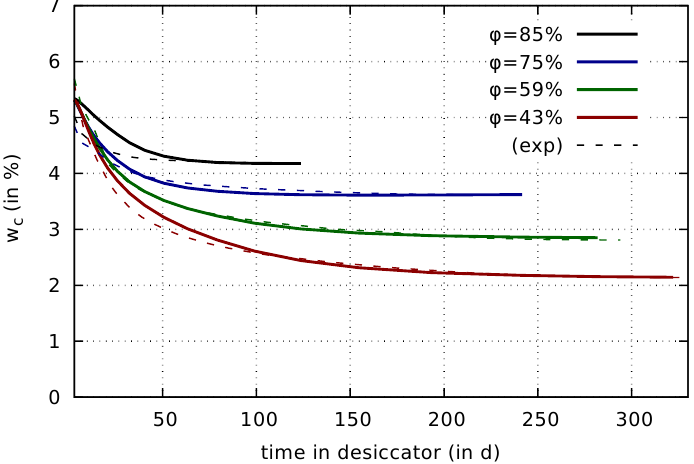
Figure 5. Computed and measured (exp) evolution of the mass water content w c in thin concrete slices ( w c given with respect to the mass of the dry